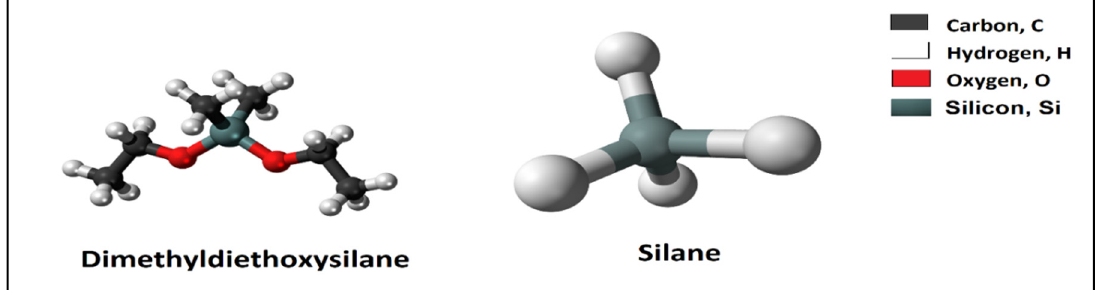
Figure 8. Chemical structure of dimethyldiethoxysilane and silane.